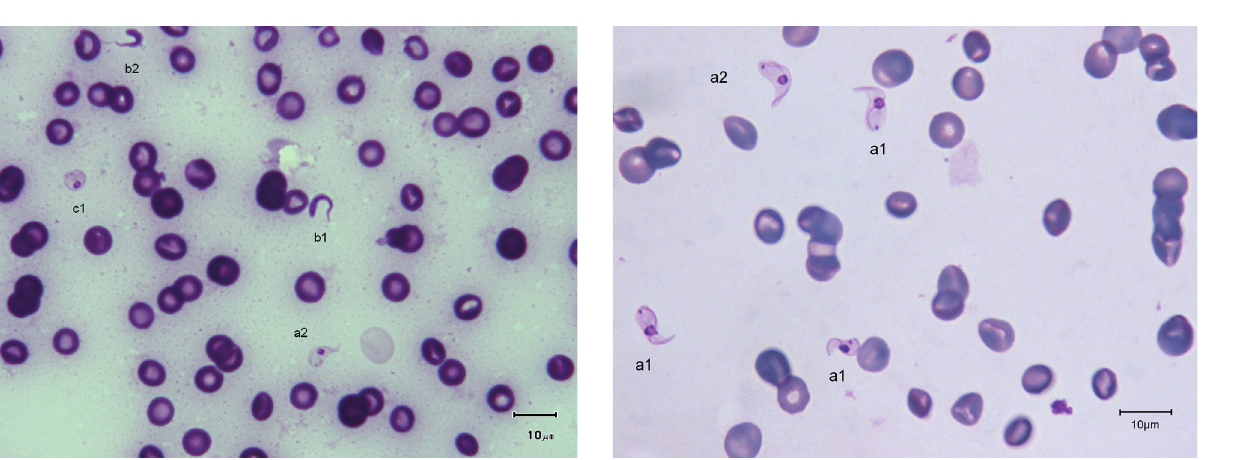
Fig. 2. – Typical T. (Nannomonas) hyperpachymorph with C-shaped (a2) and S-shaped tight flagellum (a1; three specimens). Photo by Bruno Polack.